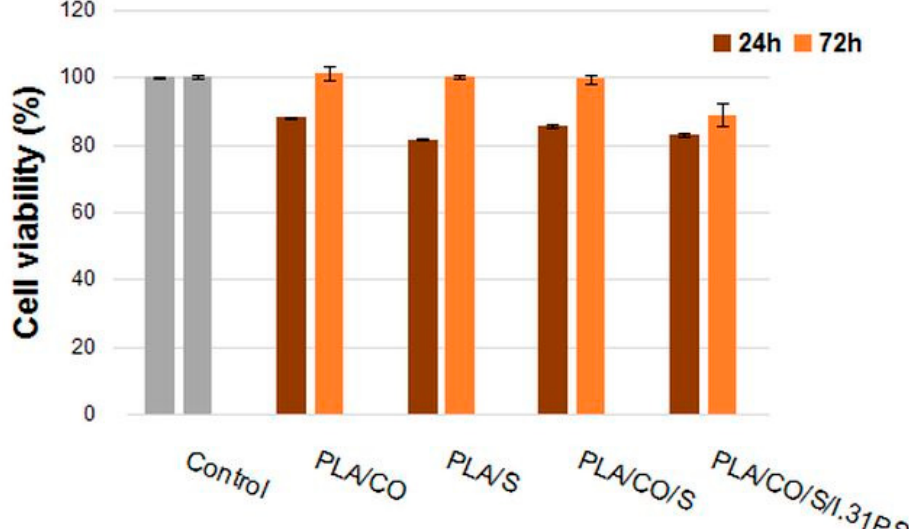
Figure 9. Viability of NCTC mouse fibroblasts cultivated in the presence of PLA/CO, PLA/S, PLA/CO/S, and PLA/CO/S/I.31PS for 24 h and 72 h, evaluated using the MTT assay. Samples reported to control (untreated cells) were considered to have 100% viability. Data are expressed as mean values ± SD (n = 3).